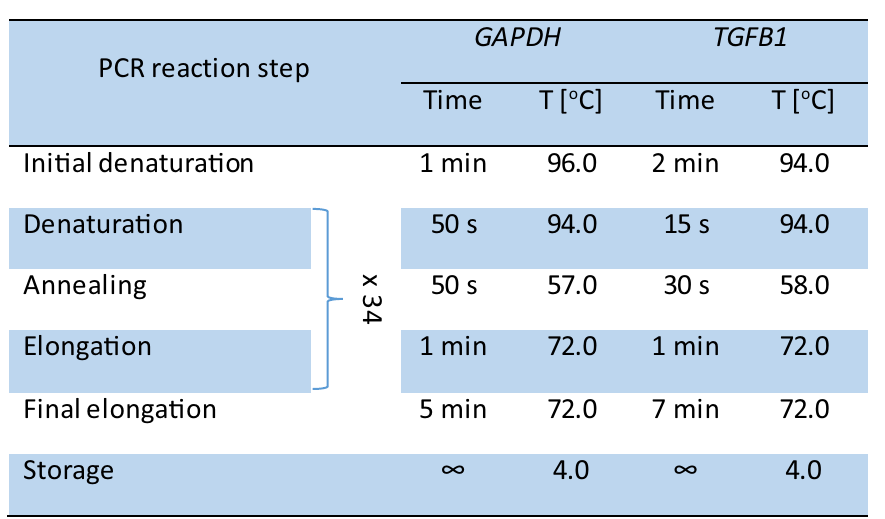
Table 2. PCR reaction conditions for the reference ( GAPDH ) and the study ( TGFB1 )